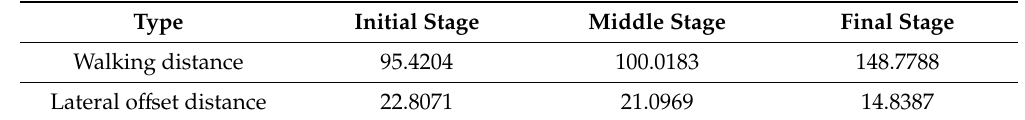
Table 6. Average experimental results at each stage (unit: cm).